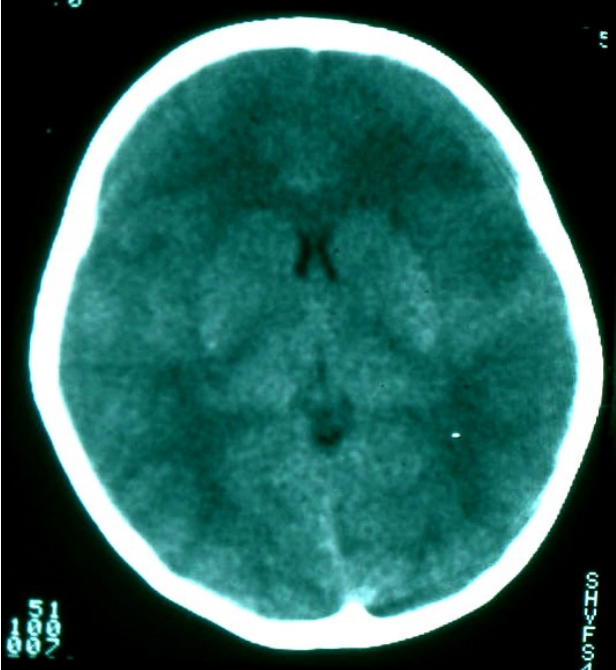
Figure 1: Computerized Axial Tomography (CAT) image of a severe cerebral edema in a child with severe scorpion